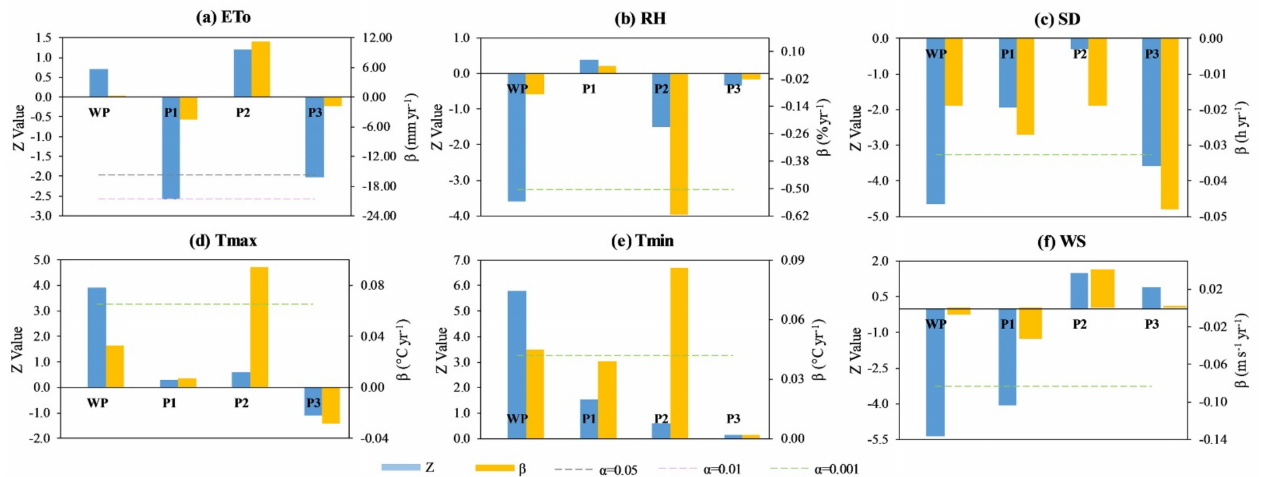
Figure 7. Z values and change rates ( β ) of climatic factors for the whole THM during different periods ( a ) ETo; ( b ) RH;( c ) SD; ( d ) Tmax;( e ) Tmin; ( f ) WS during 1973–2016 (WP), 1973–1990 (P1), 1990–1997 (P2), and 1997–2016